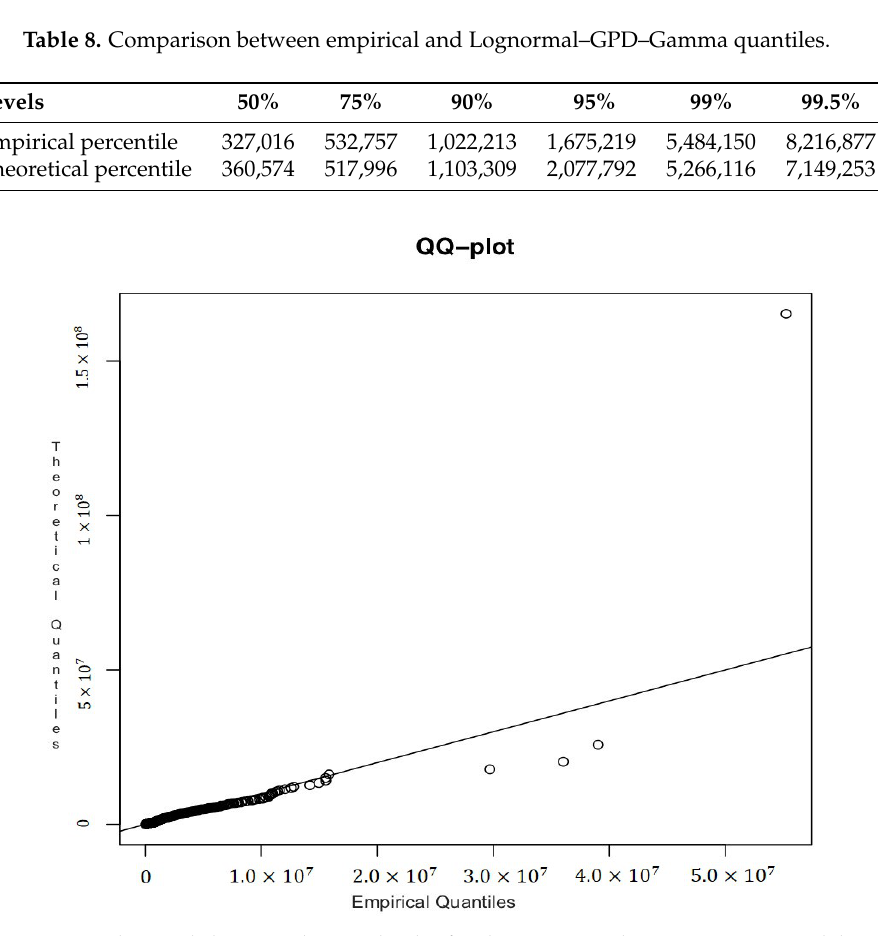
Figure 8. Observed-theoretical quantile plot for the Lognormal–GPD–Gamma